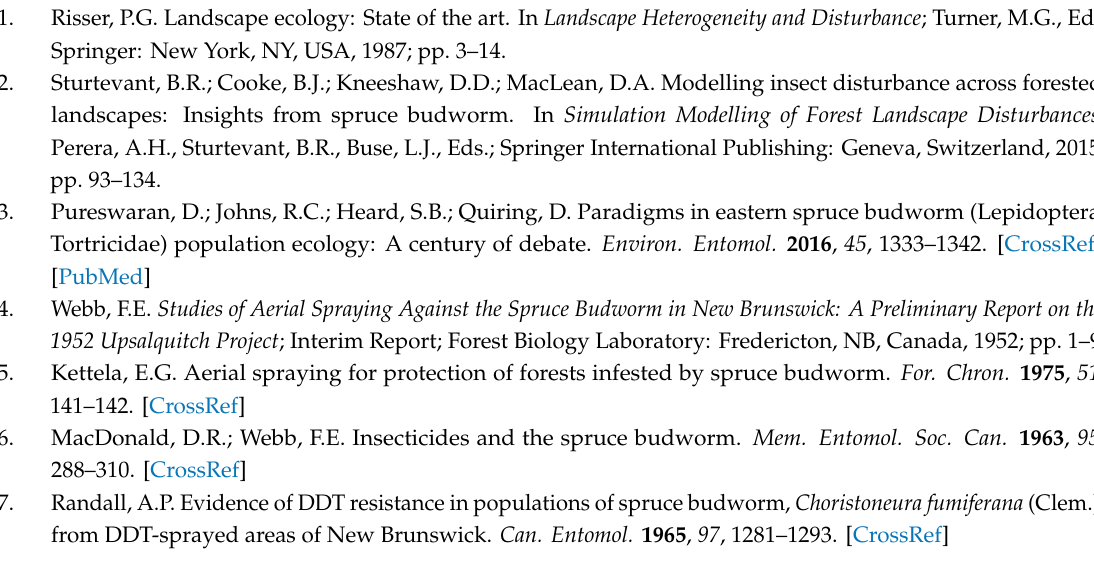
Table S1: Patterns and causes of periodic outbreaks, according to two contrasting theories, and how to optimally manage populations under each set of